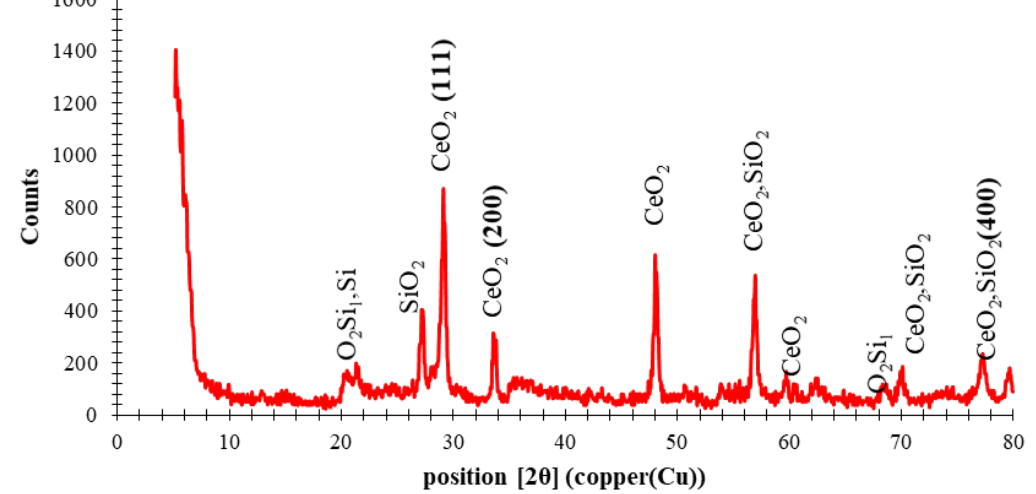
Figure 3. The XRD graph of the nanocomposite used for precise determination of the crystalline phase and size of the nanocomposite. The morphology of CeO 2 @Nanoclay nanocomposite is calcined. CeO 2 is the predominant phase based on the diffraction patterns of CeO 2 nanoparticles with different patterns of SiO 2 .